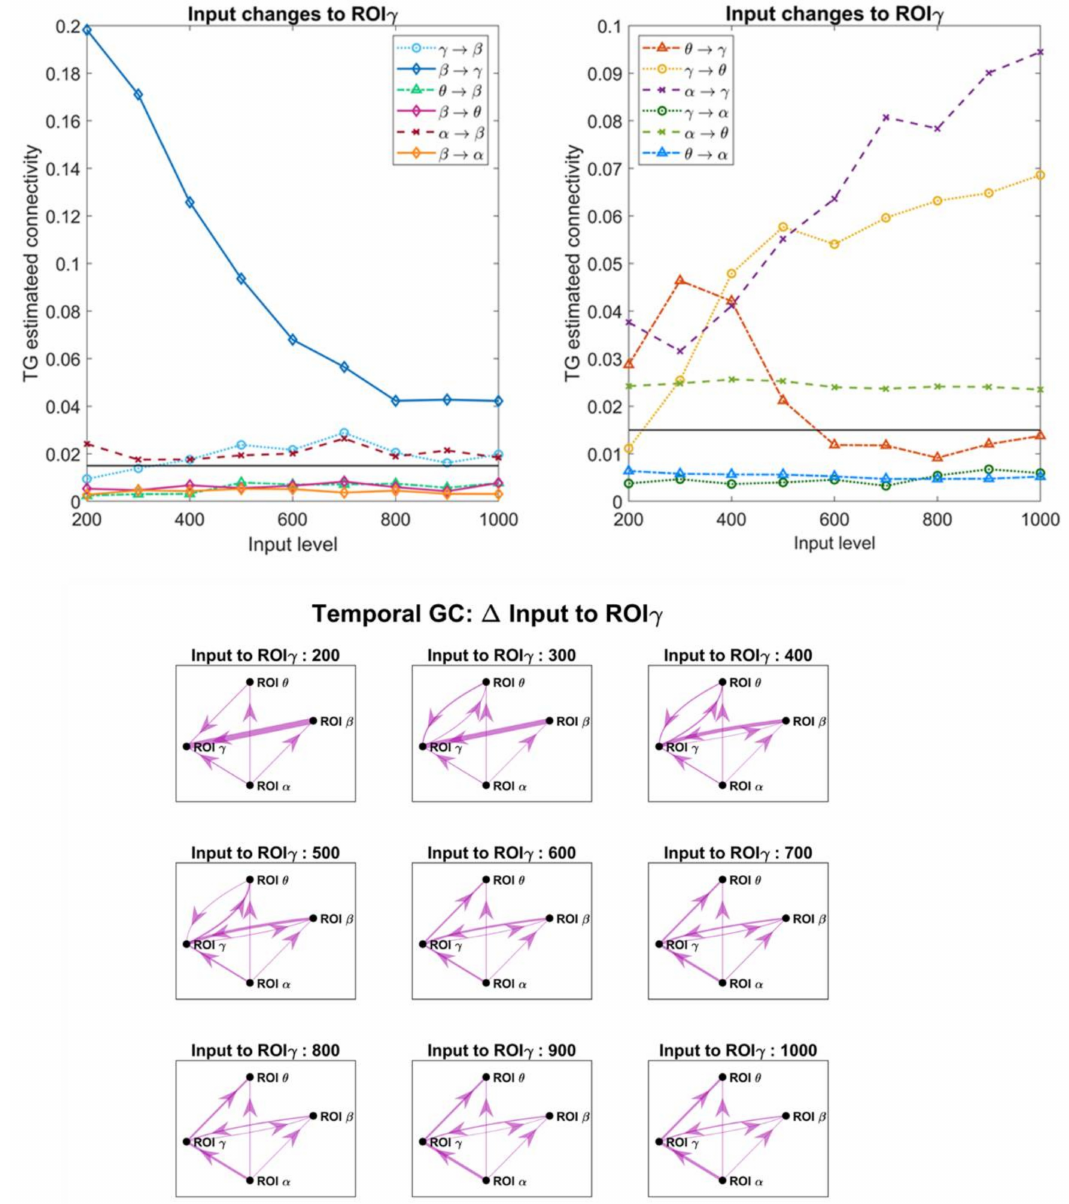
Figure 8. Upper panels: Values of connectivity among the ROIs estimated with the temporal Granger causality, with reference to the network in Figure 2A, when the input to pyramidal neurons in ROI γ was progressively varied from 200 to 1000, as in the x -axis, and all other inputs and connections were maintained at the basal value, as in Figure 2A. It is worth noting the strong effect that the input change has on several connections which involve the ROI γ . Bottom panels: connectivity graphs obtained from the estimates using a threshold as low as 0.015 (the threshold is depicted as a horizontal black line in the upper